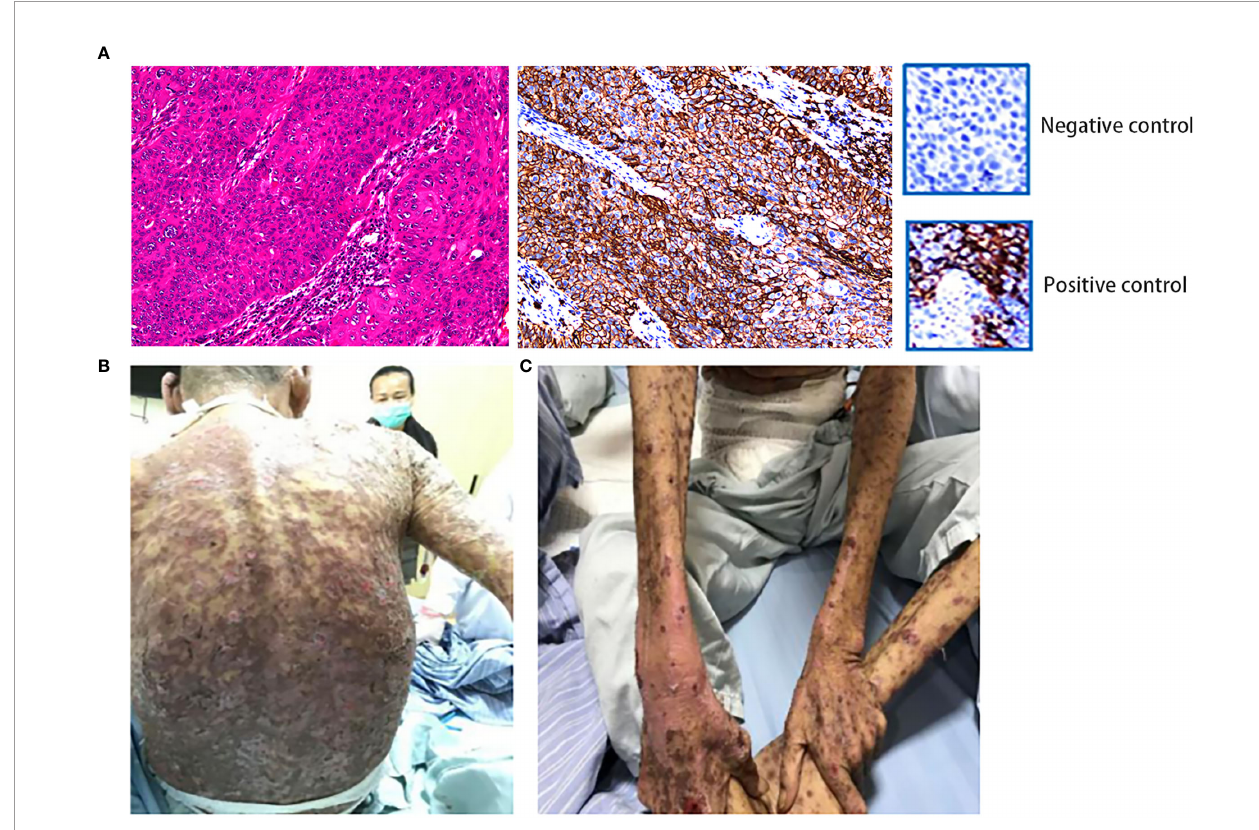
FIGURE 2 | (A) IHC showed positivity for PD-L1. (Dako 22C3 antibody was used to provide positive control and negative control.) This specimen was sliced from formalin- fi xed paraf fi n-embedded tissue. (B, C) The patient developed grade IV drug-induced dermatitis after the fi rst course of combination therapy with sintilimab and nimotuzumab. HE, hematoxylin – eosin; IHC, immunohistochemistry; PD-L1, programmed death-ligand